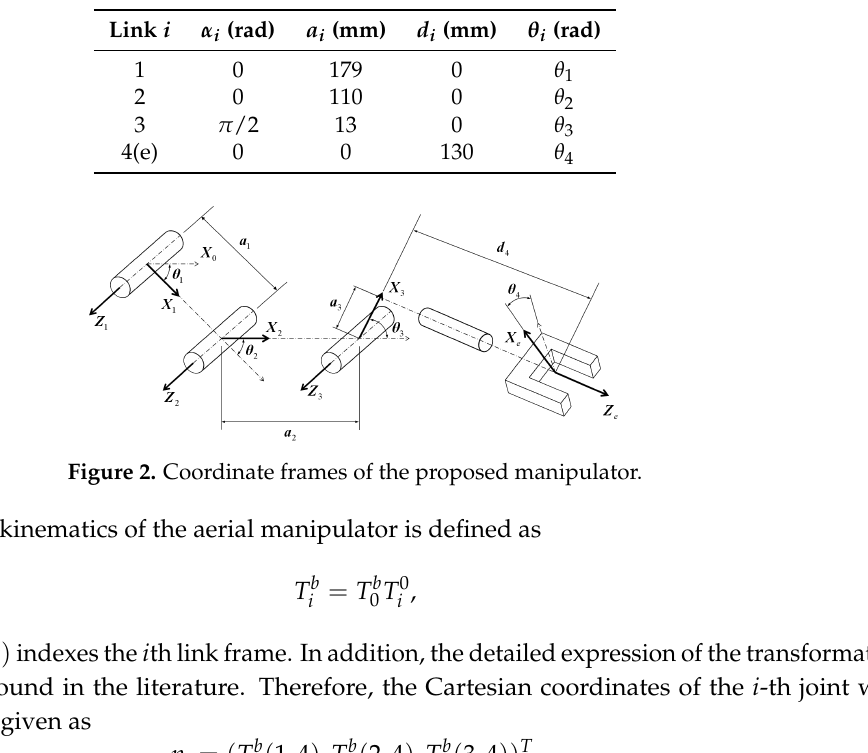
Table 1. Denavit–Hartenberg parameters.